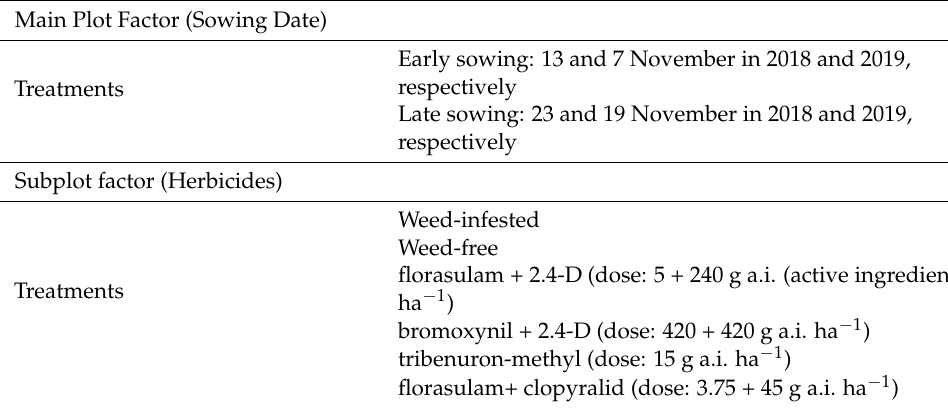
Table 2. Description of treatments for sowing date and herbicides. Main Plot Factor (Sowing Date) Early sowing: 13 and 7 November in 2018 and 2019, Treatments